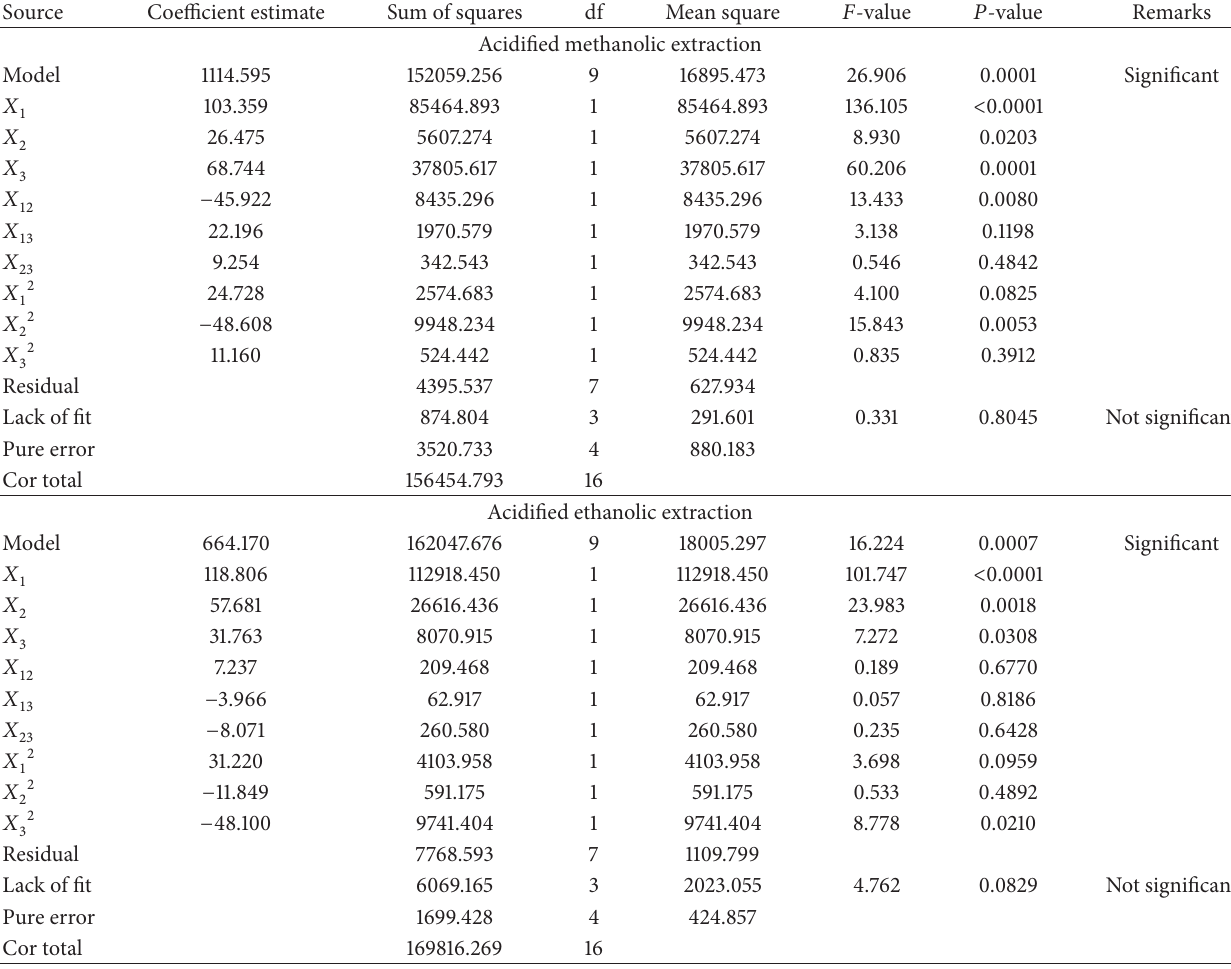
Table 3: ANOVA for response surface quadratic model.